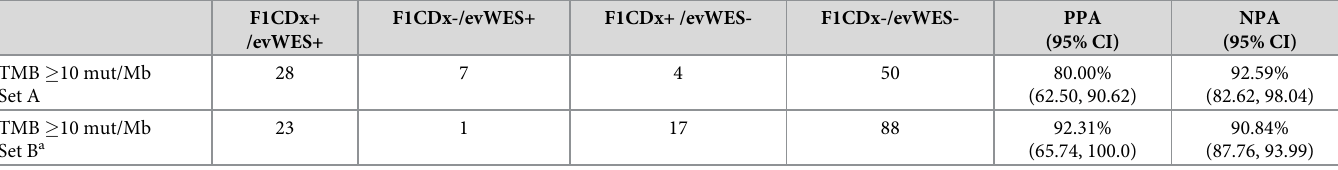
Table 12. Concordance of F1CDx and an externally validated WES for TMB-High with � 10 mut/Mb as cut-off.